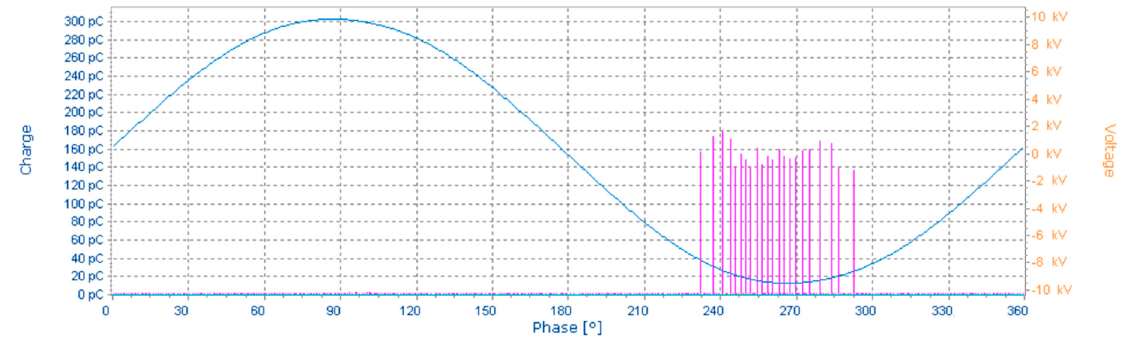
Figure 15. Oscillogram for 7 kV, needle-plane arrangement.